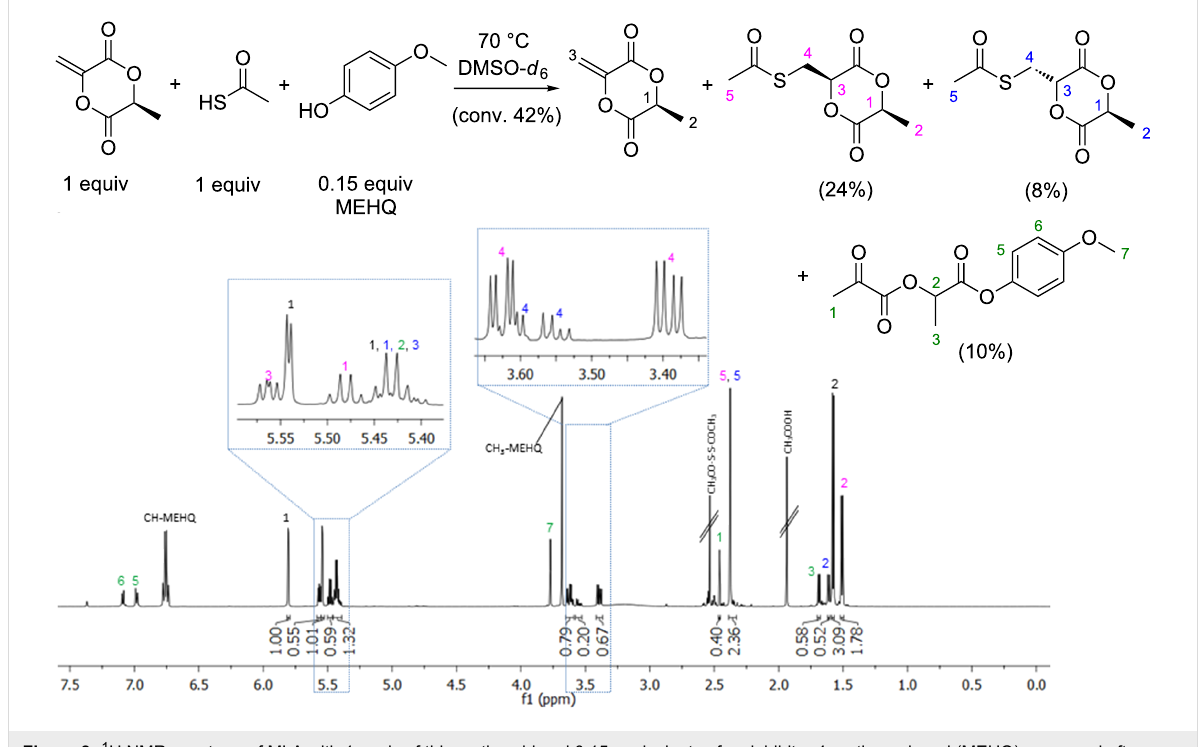
Figure 8: 1 H NMR spectrum of MLA with 1 equiv of thioacetic acid and 0.15 equivalents of an inhibitor 4-methoxyphenol (MEHQ) measured after 30 min at 70 °C in a NMR spectrometer (600 MHz, DMSO- d 6 , 70 °C, c MLA = c Thioacetic acid 0.5 mol ∙ L − 1 ).